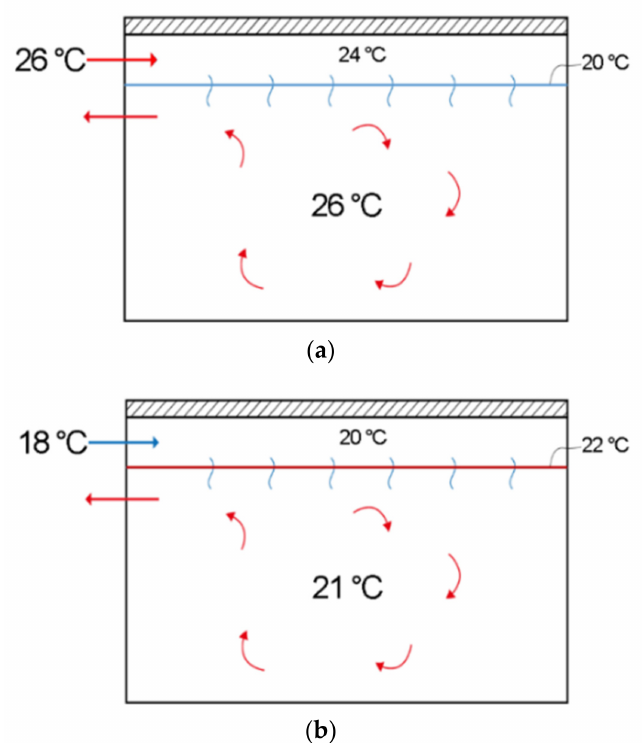
Figure 1. The HVACeiling concept [10] for ( a ) cooling mode; ( b ) heating